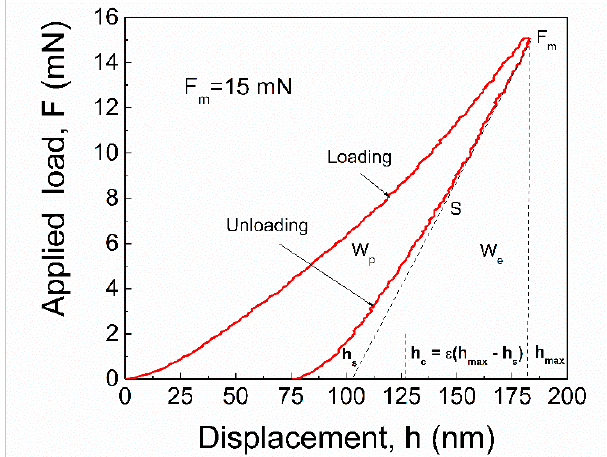
Figure 1. Typical load-displacement curve at the maximum load of 15 mN in the case of an AlN film deposited at 800 °C, in 0.1 Pa N 2 pressure and with a laser pulse frequency of 40 Hz.